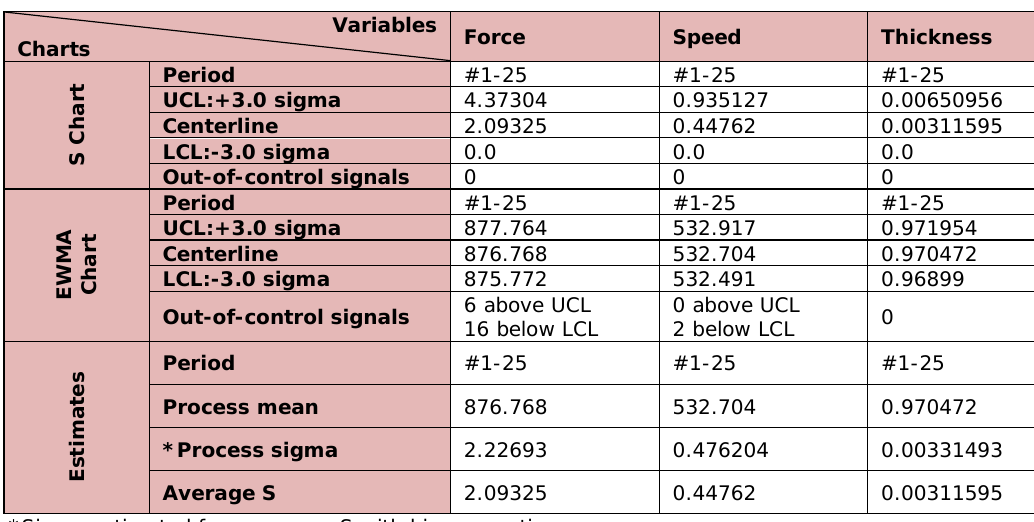
Table 3. “EWMA and S charts parameters of force, speed, and